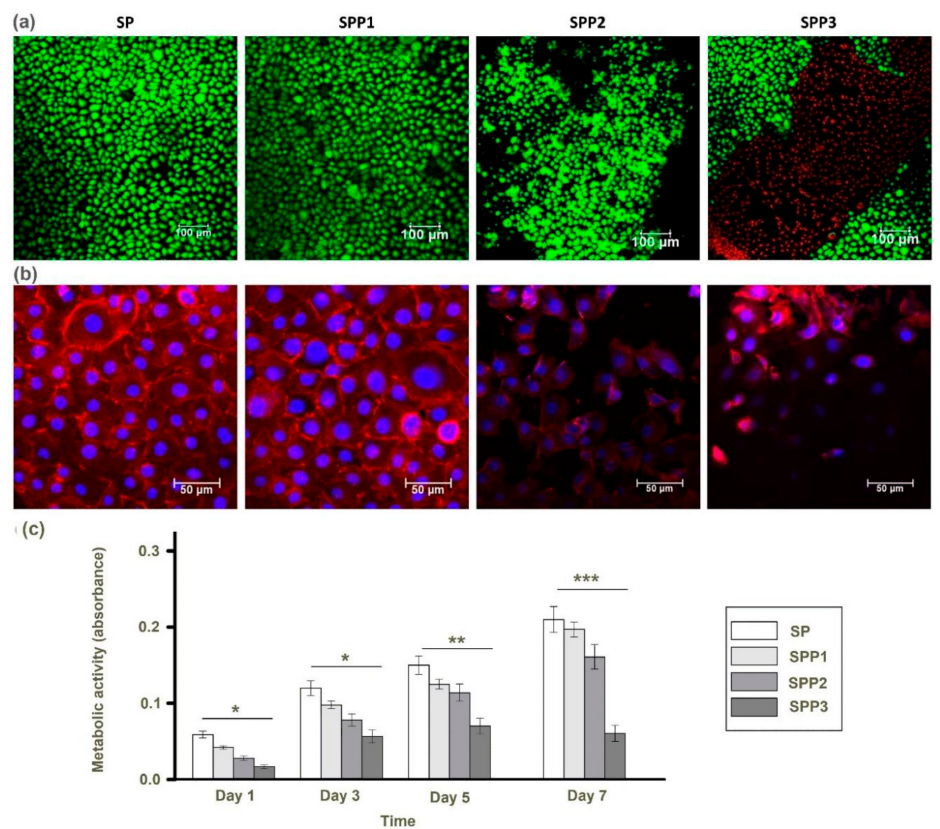
Figure 3. ( a ) Viability of cells on di ff erent matrices (live cells appear green and dead cells red) Scale bar = 100 µ m. ( b ) Cytoskeletal organization of corneal epithelial cells after 7 days in culture after staining actin filaments (red) and nuclei (blue). Scale bar = 50 µ m. ( c ) Total cell metabolism on di ff erent composite matrices evaluated by the Presto-blue assay (* p < 0.05, ** p < 0.01, *** p <